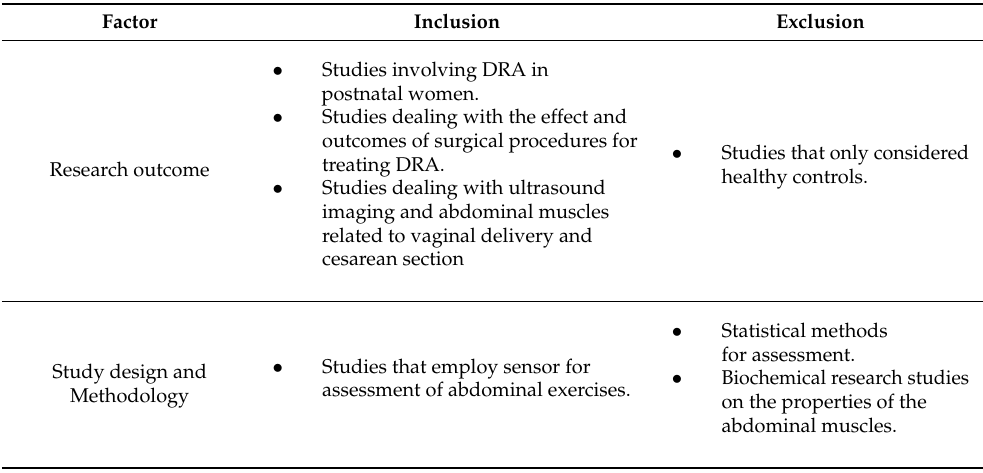
Table 1. Exclusion and Inclusion